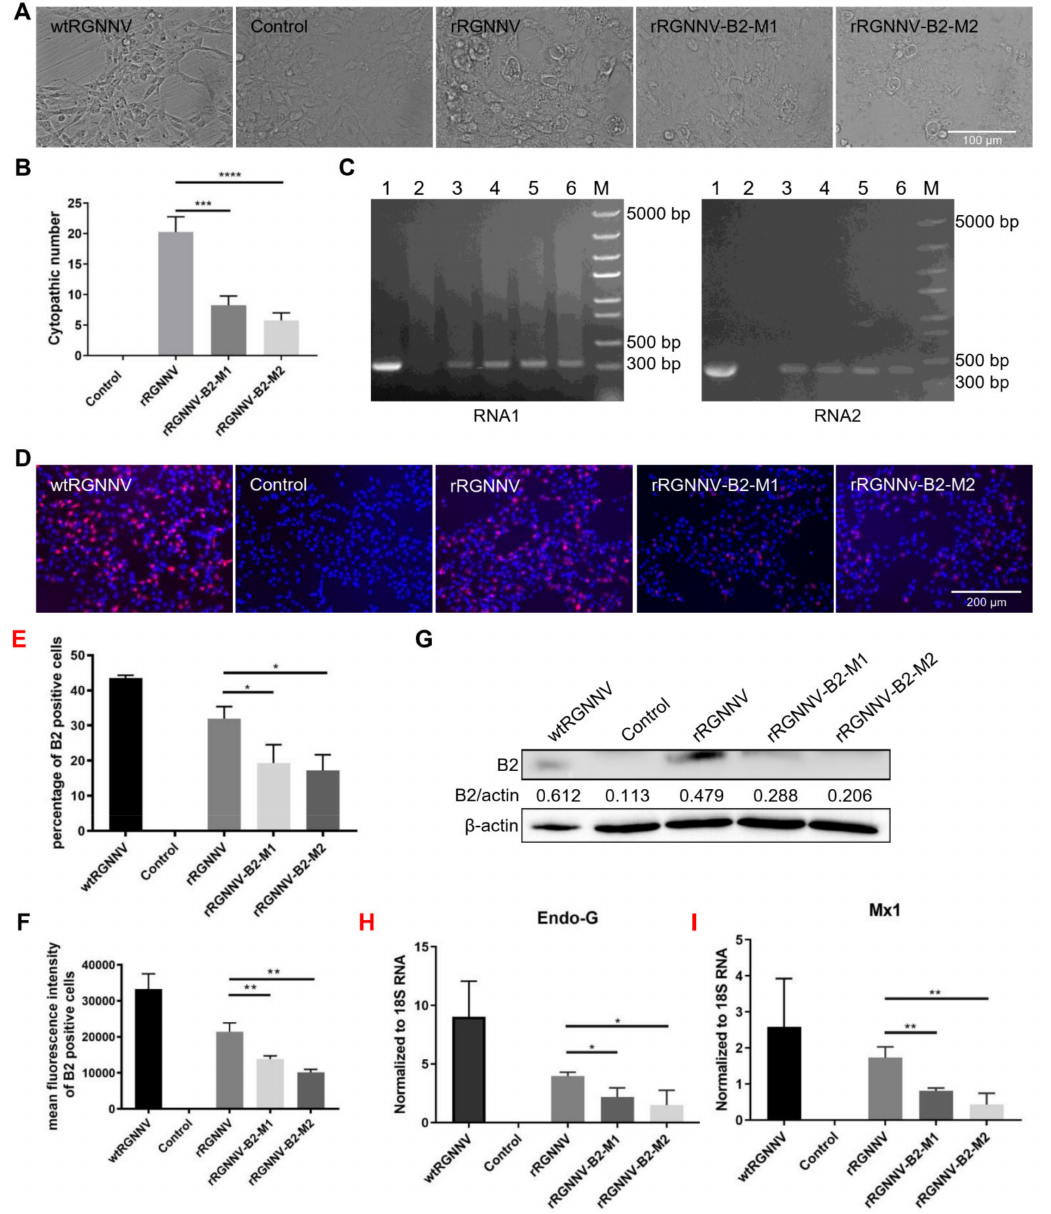
Figure 3. Biological characteristics of wtRGNNV, rRGNNV, rRGNNV-B2-M1, and rRGNNV-B2-M2 viruses. ( A ) CPE of recombinant RGNNV in SSN-1 cells. SSN-1 cells were incubated with wtRGNNV, rRGNNV, rRGNNV-B2-M1, and rRGNNV-B2-M2, and the CPE was observed at 3 dpi. ( B ) The CPE number statistics (*** p < 0.001; **** p < 0.0001). ( C ) Detection of RNA1 and RNA2. RGNNV